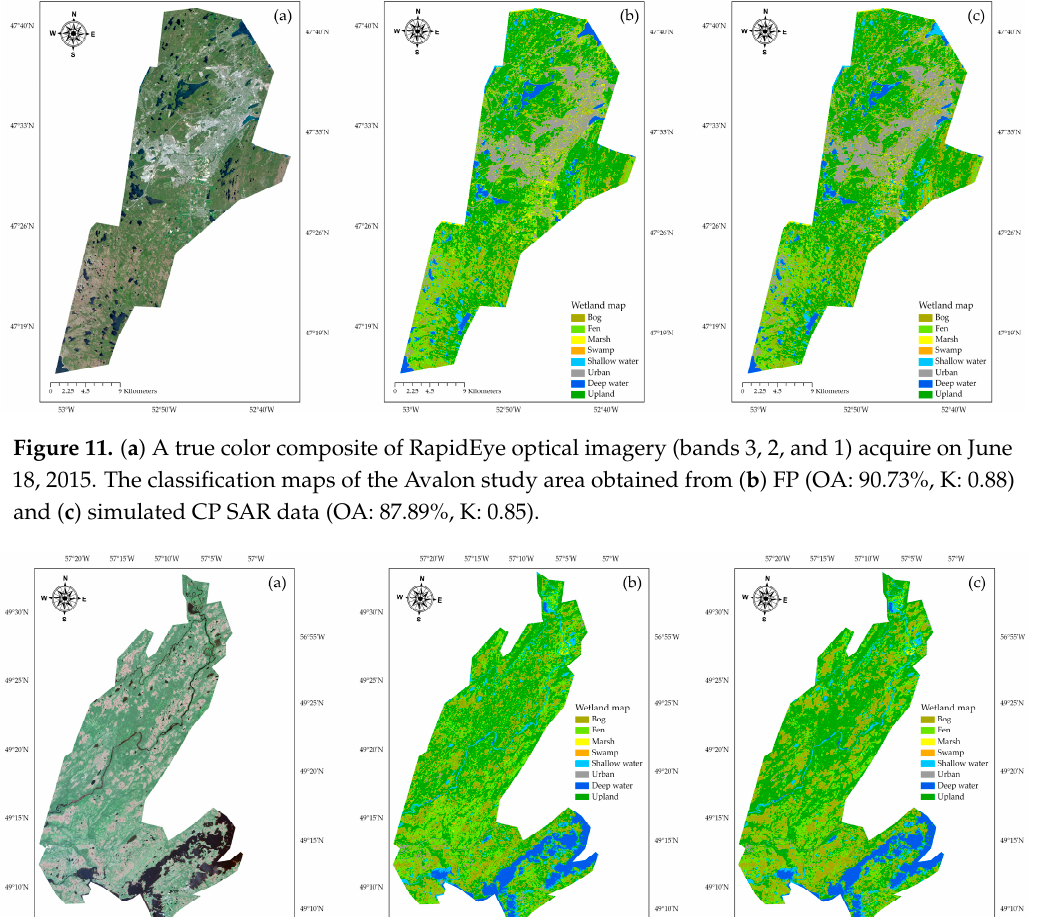
18 of 25 effort was devoted to collecting in-situ data from this site, compared to those of other sites. Figures